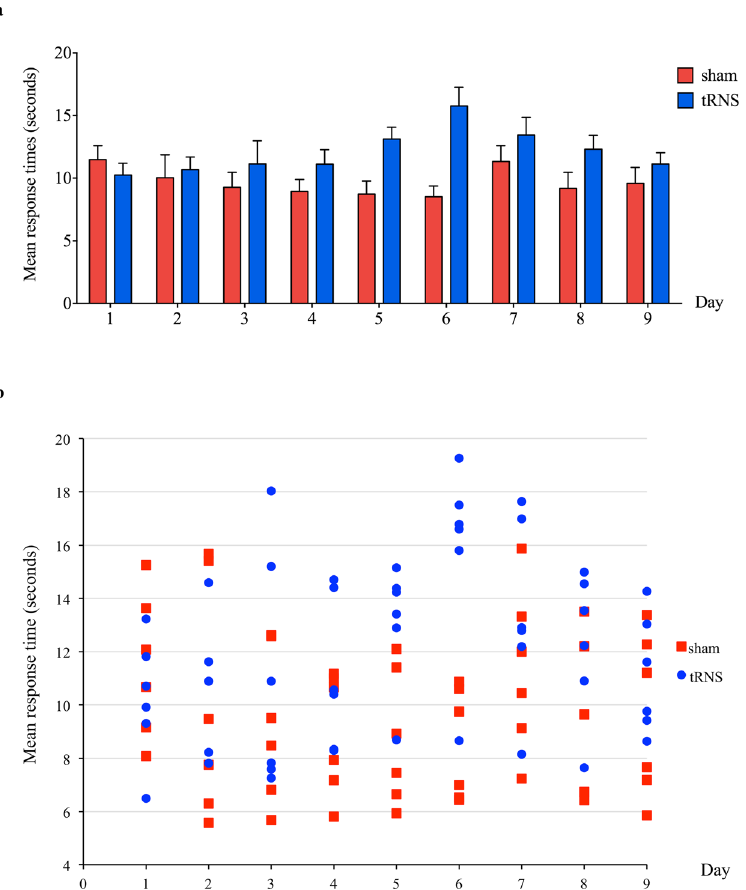
Figure 4. Sham group showed reduced response times with day compared with the real tRNS group, but was not associated with speed-accuracy trade-off ( a ) Bar graph displays the mean response time of each group on each training day. Error bars represent one standard error of the mean (SEM). ( b ) Scatter plot shows the mean response times of each individual on each training day, labelled by